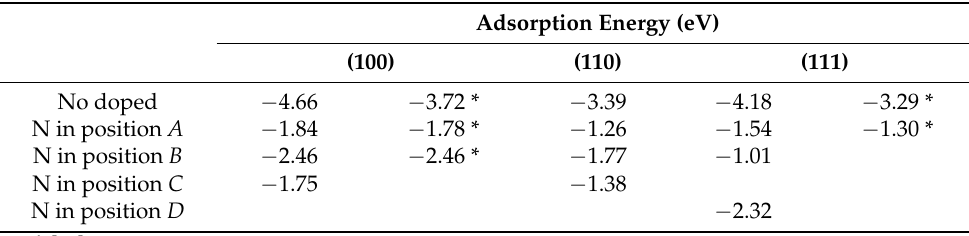
Table 2. Methyl molecule adsorption energy E CH 3 with or without nitrogen doping at positions A , B , C , and D .